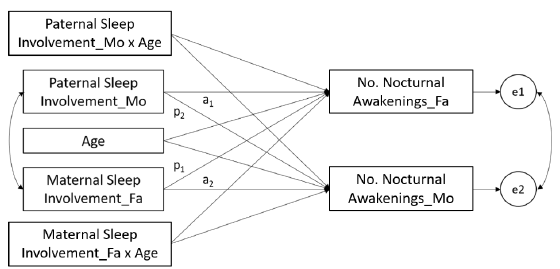
Figure 1. Moderated actor–partner interdependence model (APIM) model. Mo: Reported by mothers; Fa: Reported by fathers; No.: Number; a 1 and a 2 : Actor e ff ects; p 1 and p 2 : Partner e ff ects; e1 and e2: Measurement